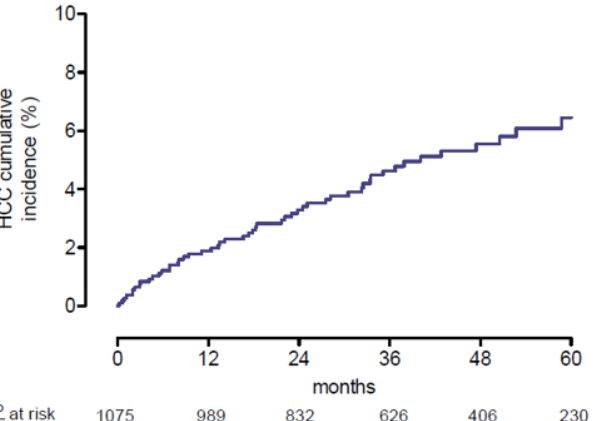
Figure 2. Five-year cumulative incidence of hepatocellular carcinoma (HCC) in patients with chronic hepatitis C treated with direct-acting antiviral drugs.